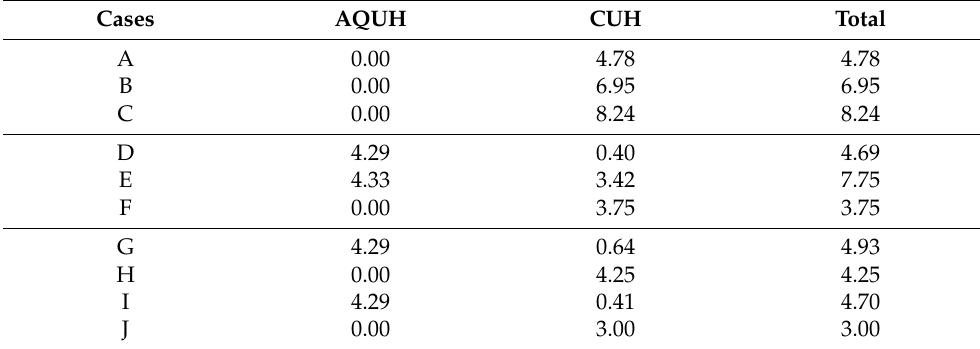
Table 5. Air quality uncomfortable hours (AQUH) and cold uncomfortable hours (CUH) in each case study.